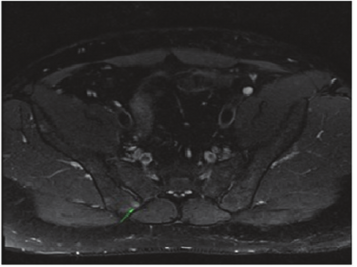
Figure 2: Sacroiliac joint magnetic resonance imaging was consis- tent with sacroiliitis at right posterior of the sacroiliac